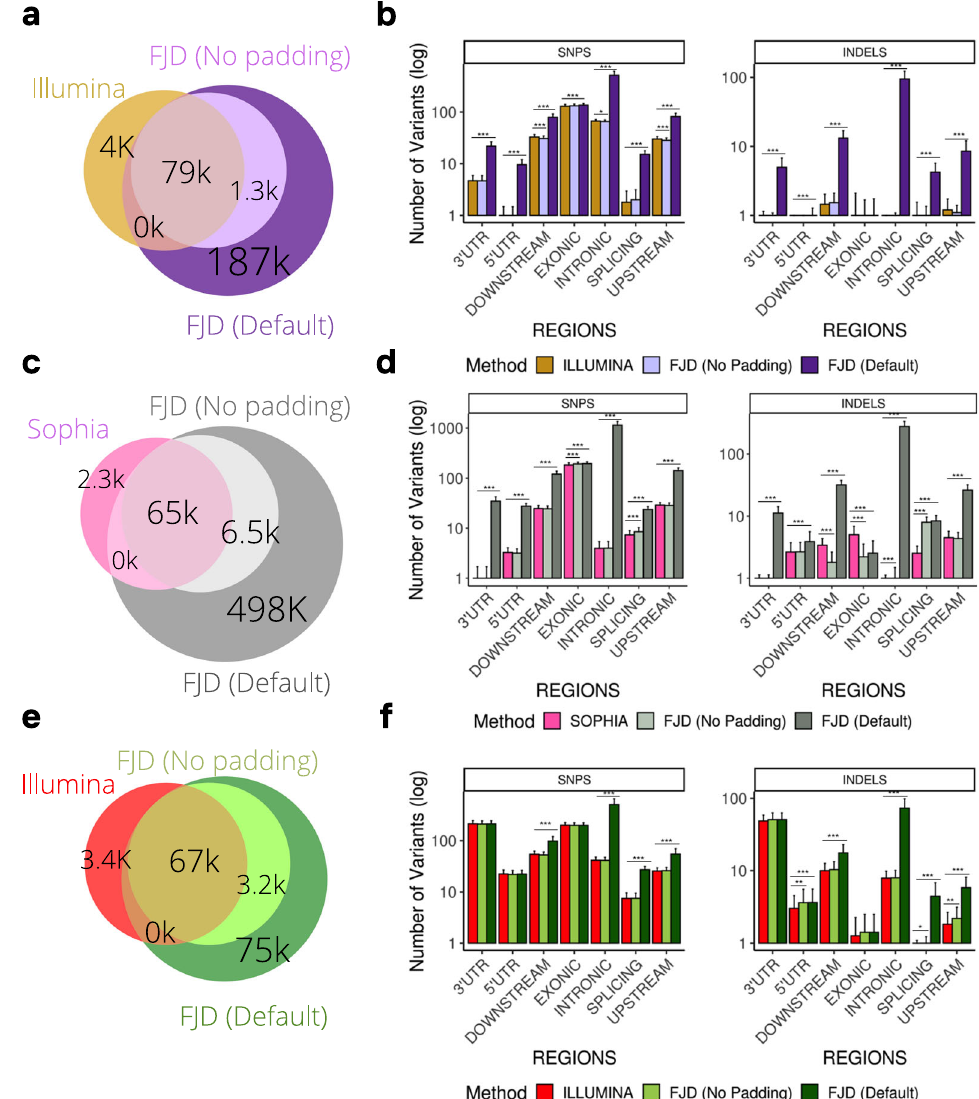
Fig. 3 Comparison of variants detected between the FJD-Pipeline and the commercial pipelines of Illumina and Sophia in the cancer and cardio cohorts. Venn diagrams showing the overlap of variants detected between the FJD-pipeline and the commercial pipeline: ( a ) Illumina -TSCancer, ( c ) Sophia panel, ( e ) Illumina-Nextera panel. The bar plots show the average number of variants (variant count) detected by the FJD-pipeline and the commercial pipelines ( b ) Illumina-TSCancer Panel, ( d ) Sophia, ( f ) Illumina- Nextera Panel, in each type of genomic region, the distributions are shown using the mean and standard deviation for visual ease. Signi fi cant differences between values are indicated by asterisks: * p < 0.05, ** p < 0.01, *** p <